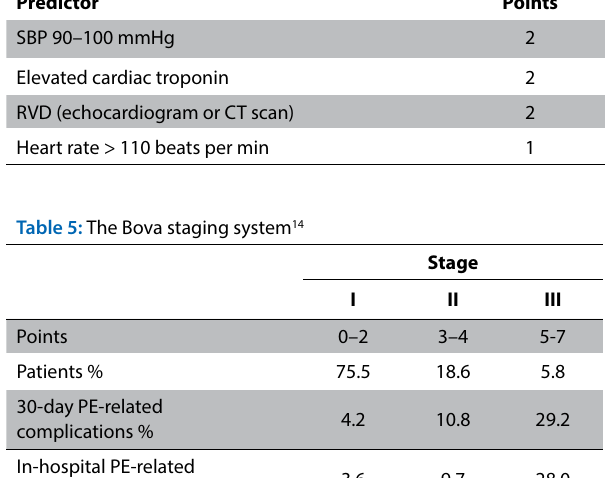
Table 4: Risk Scores based on the Bova Model 14 Predictor Points